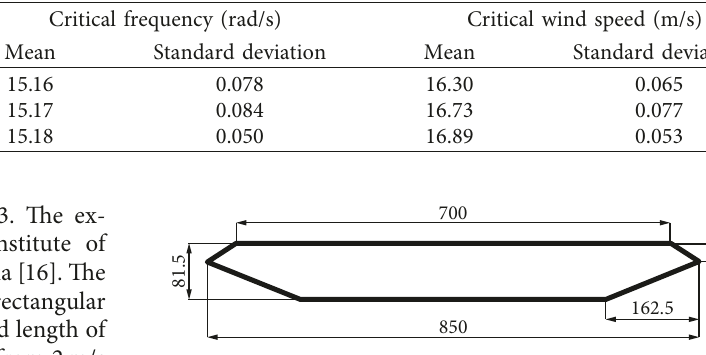
Figure 3: Deck section dimensions and shape (unit: